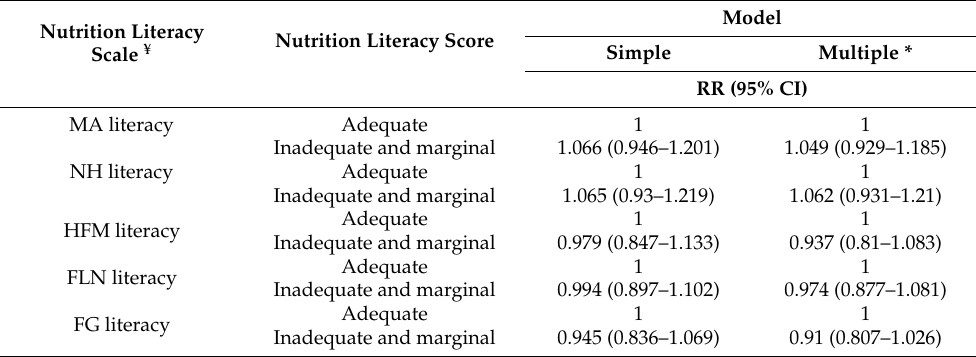
Table 3. The relative risk of being affected by overweight or obesity with inadequate nutrition literacy in the different components of the nutrition literacy scale ( n = 189).